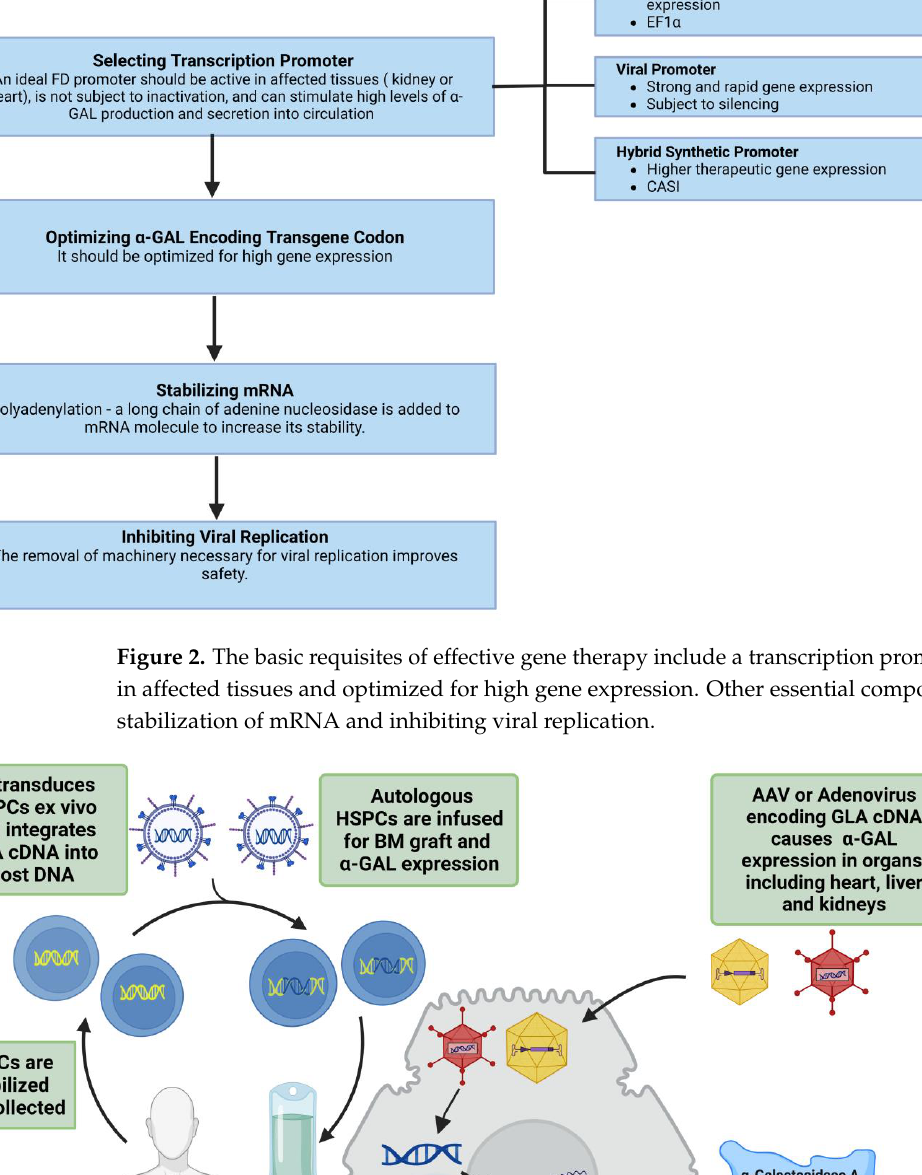
thalassemia, have shown long-term safety [76].